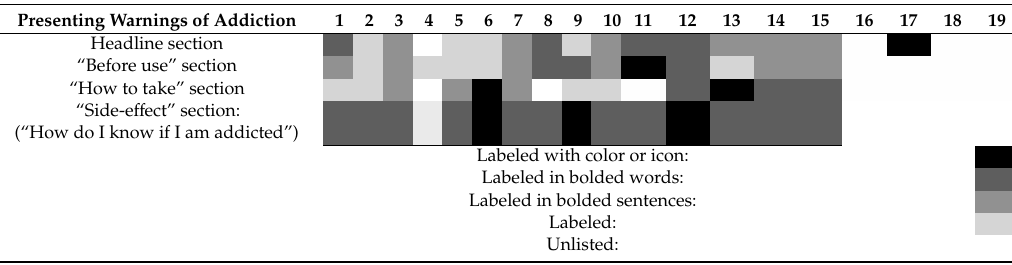
Table 3. Investigating the presentation for warnings of addiction.